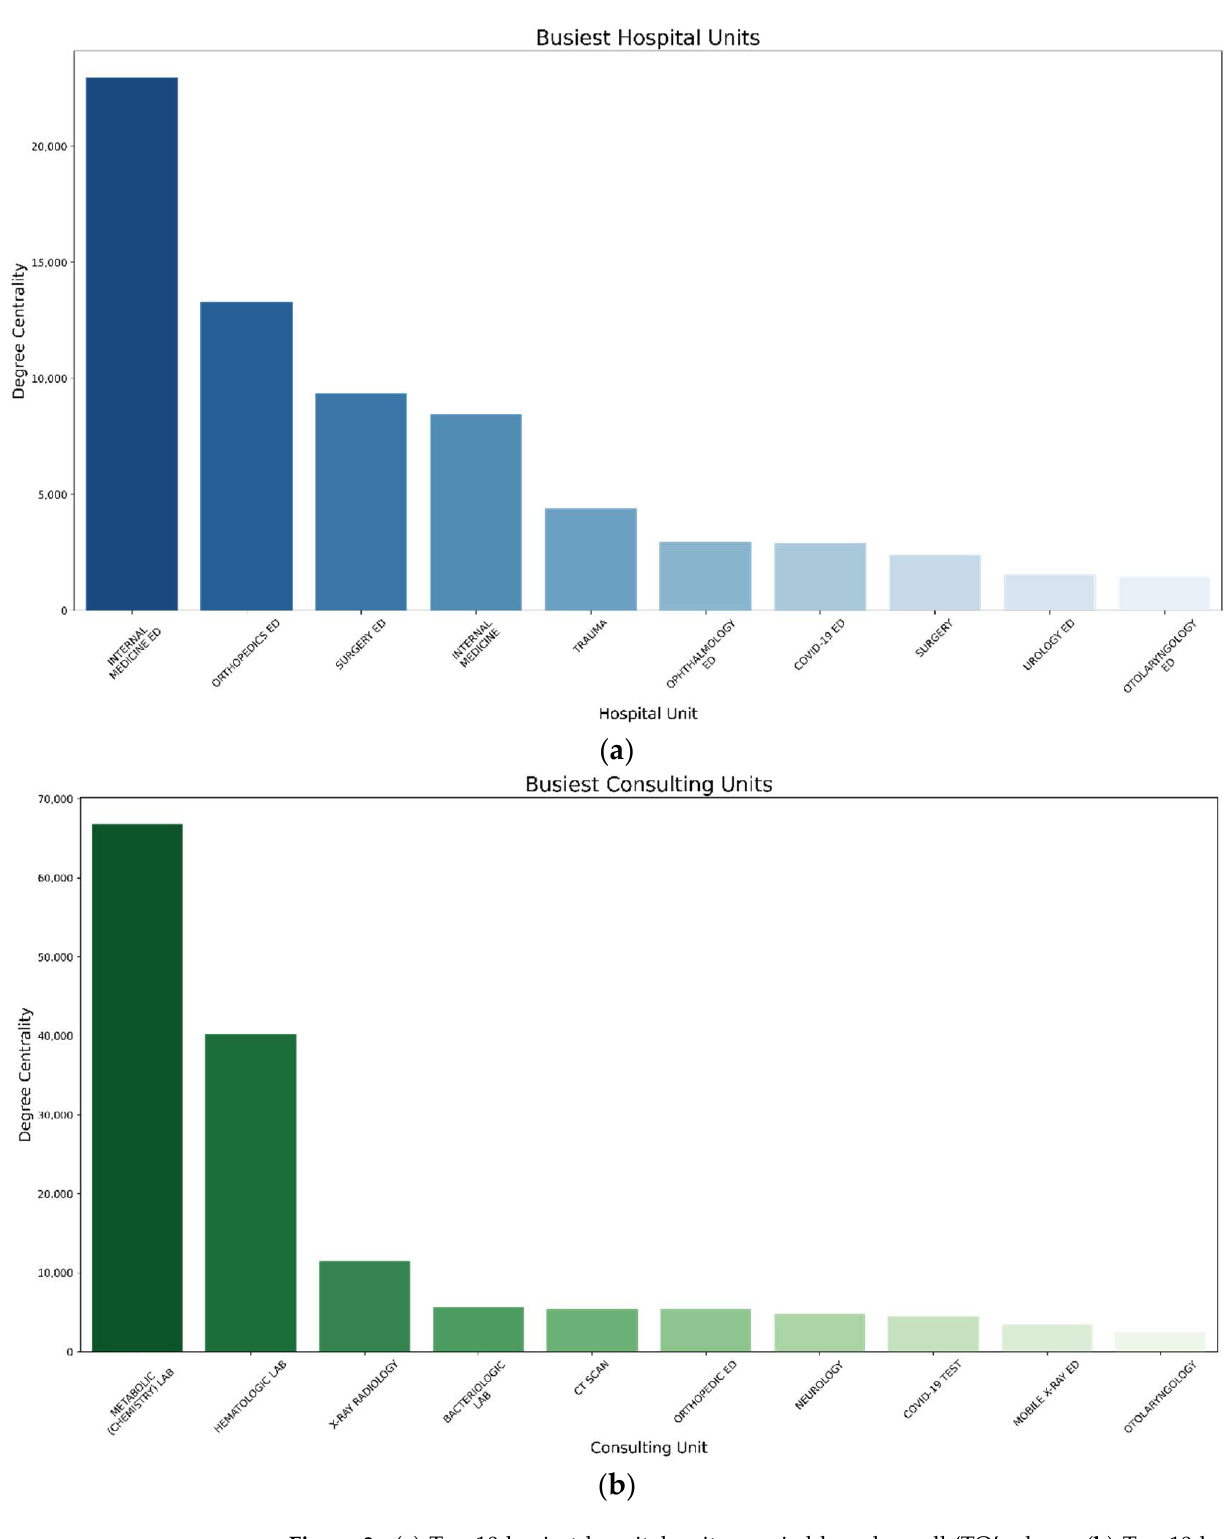
Figure 3. ( a ) Top 10 busiest hospital units queried based on all ‘TO’ edges. ( b ) Top 10 busiest consulting units queried based on all ‘ORDER_TO’ edges.